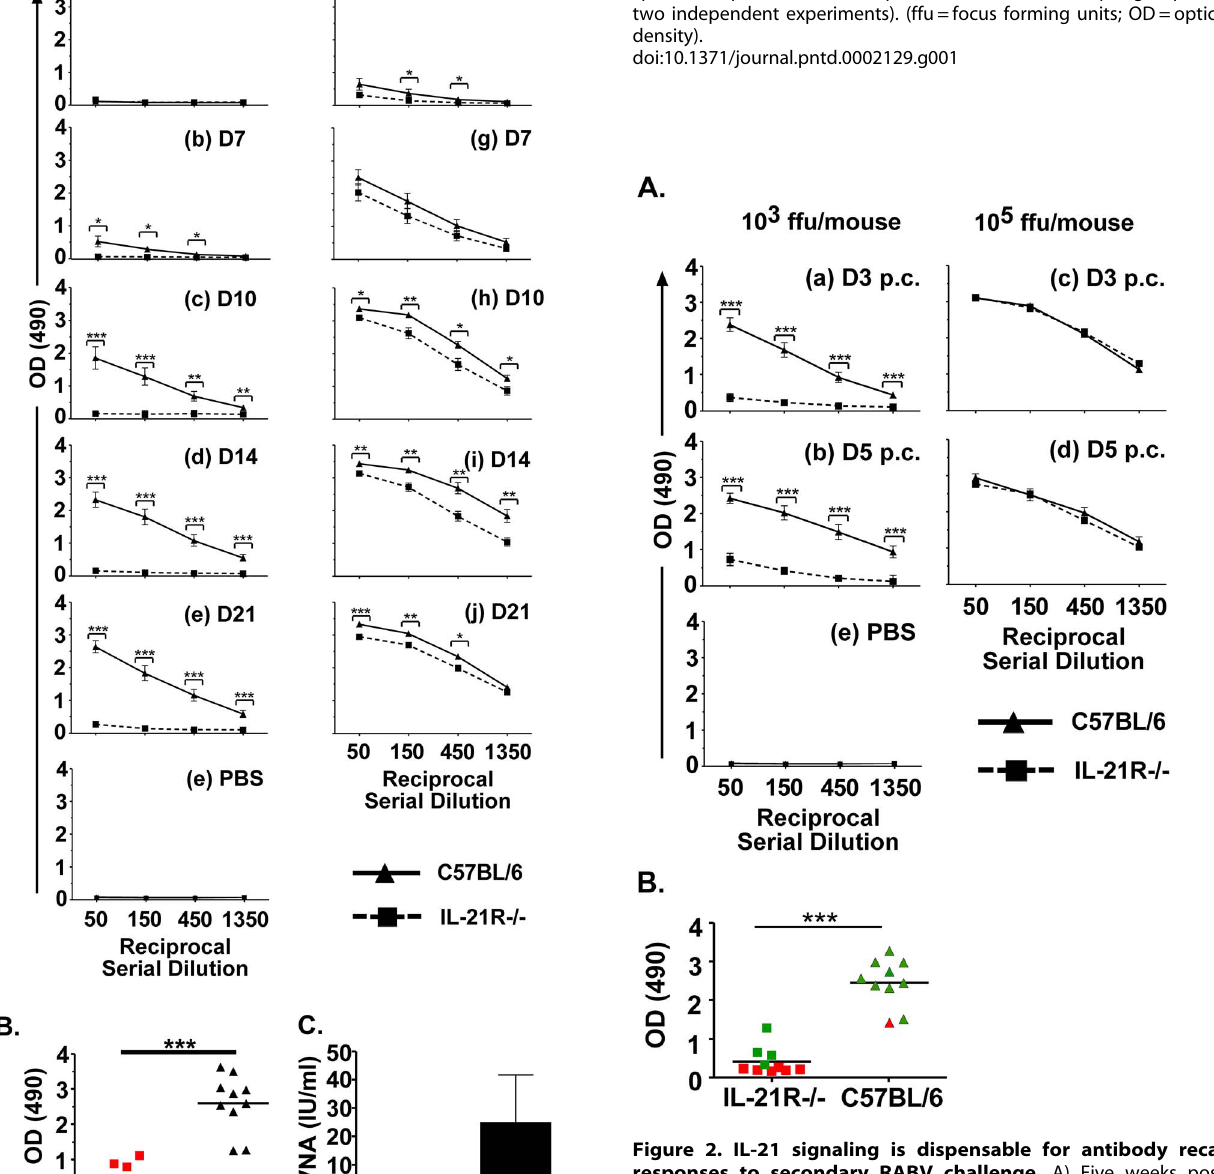
PLOS Neglected Tropical Diseases |